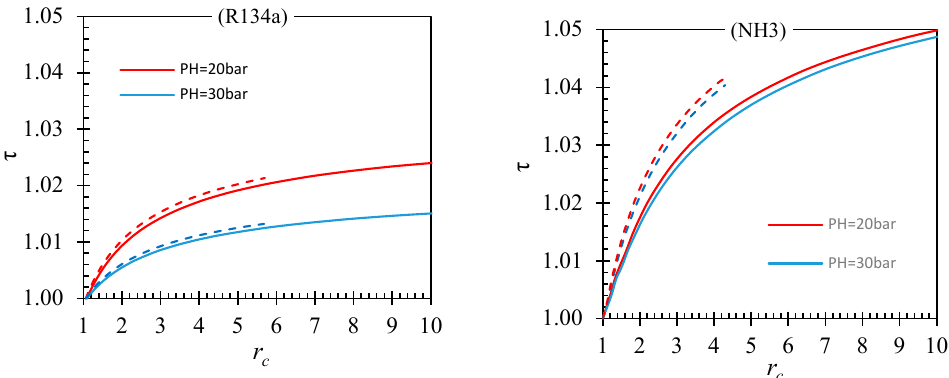
Figure 9. Dimensionless temperatures of the driving R134a ( left ) and ammonia ( right ) at the end of compression stroke as a function of the compressor pressure ratio; solid lines—adiabatic compression, dashed lines—isothermal compression.